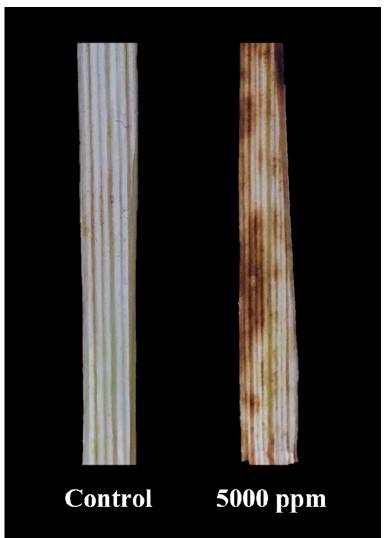
Figure 7. Effect of SCE treatment on H 2 O 2 content of Festuca arundinacea . Error bars represent standard deviations. Each data point represents the mean of at least six replications. Bars with different letters are significantly different from each other at p ≤ 0.05.